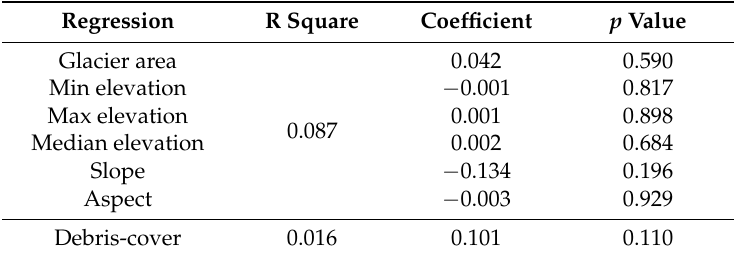
Table 6. Regression between glacier area change and glacier parameters (84 observations) and regression between glacier area change and debris-cover (52 observations).